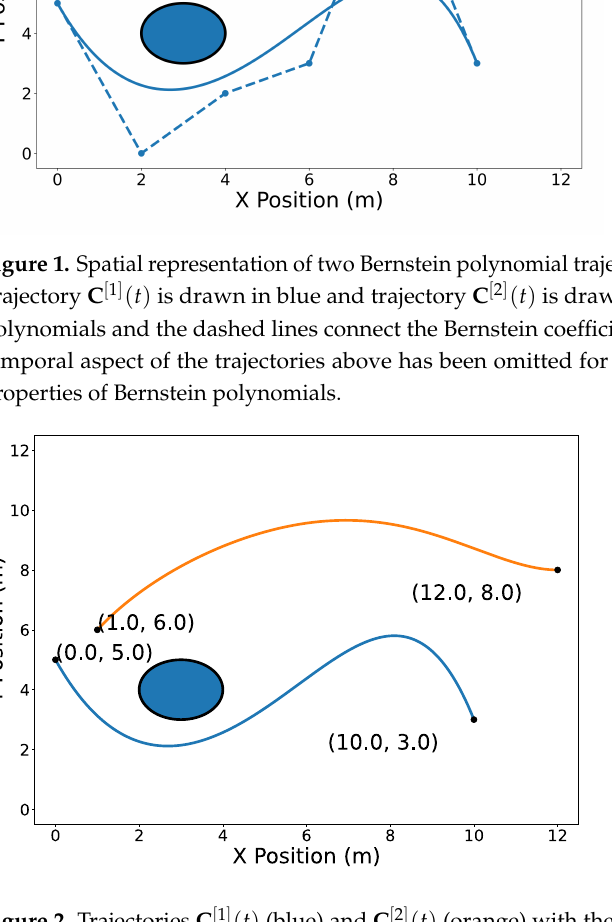
Figure 2. Trajectories C [ 1 ] ( t ) (blue) and C [ 2 ] ( t ) (orange) with their endpoints highlighted in